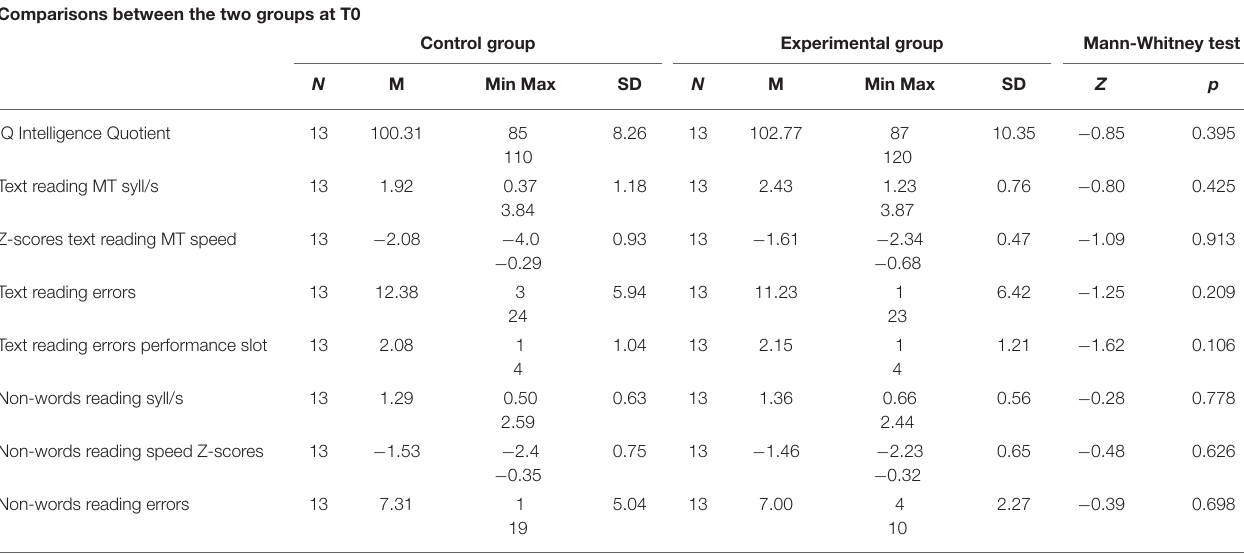
TABLE 3 | Scores of the two groups in T0 (pre training phase): number of subjects (N), mean (M), minimum value (Min) and maximum value (Max), standard deviation (SD) calculated on raw and Z-scores. Comparisons between the two groups at T0 Control group Experimental group Mann-Whitney